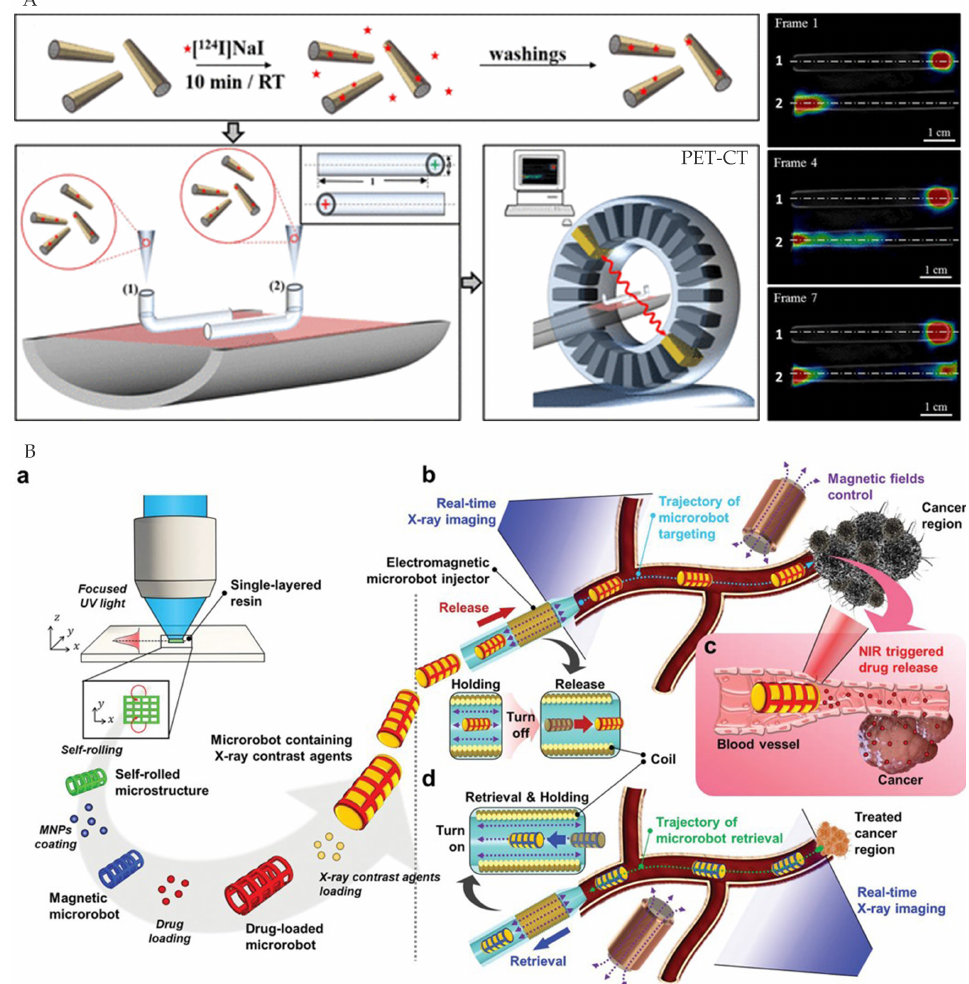
Figure 10. ( A ) Tracking by PET. Adapted with permission from [87]. Copyright 2018 American Chemical Society. ( B ) Tracking by X-ray imaging. Reproduced with permission from [88]; published by John Wiley and Sons,